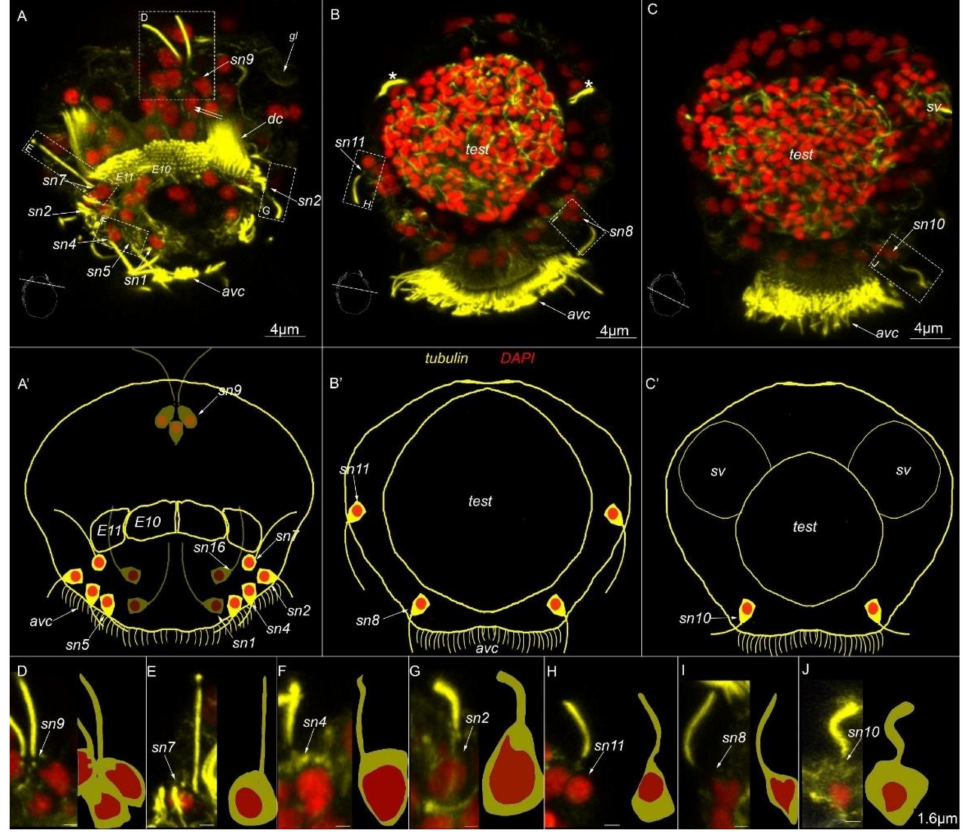
Figure 6. Type 1b sensory neurons in mature Dimorphilus gyrociliatus dwarf male revealed by anti- acetylated alpha-tubulin labeling. ( A , A (cid:48) ) A cross-section and schematic representation of the anterior surface. ( B , B (cid:48) ) A cross-section and schematic representation of the anterior part of the body. ( C , C (cid:48) ) A cross-section and schematic representation of the middle part of the body. ( D ) The close-up and drawing of sensory neuron № 9. ( E ) The close-up and drawing of sensory neuron № 7. ( F ) The close-up and drawing of sensory neuron № 4. ( G ) The close-up and drawing of sensory neuron № 2. ( H ) The close-up and drawing of sensory neuron № 11. ( I ) The close-up and drawing of sensory neuron № 8. ( J ) The close-up and drawing of sensory neuron № 10. Abbreviations: avc —anterior cilia; E10,11 —multiciliated cells of the dorsal ciliary field; dc —dorsal cilia; pvc —posterior cilia; test —testis; sv —seminal vesicles; sn1 – sn20 —sensory neurons1–20;